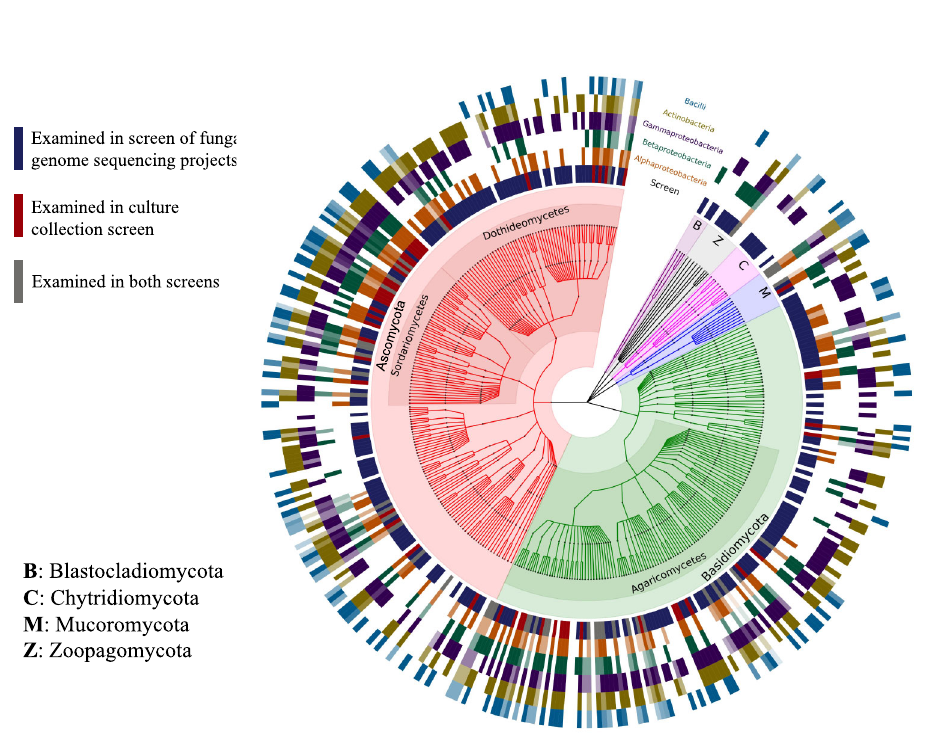
Fig. 3 Diversity of bacteria found among fungi from culture collections and public fungal genome sequencing projects. The internal cladogram is colored by fungal phyla and terminal nodes represent fungal genera. The innermost ring indicates the screen used to detect these bacterial – fungal associations, and the outer fi ve rings represent the top fi ve bacterial lineages (from inner to outer ring: Alphaproteobacteria, Betaproteobacteria, Gammaproteobacteria, Actinobacteria, and Bacilli) most frequently detected in our screens. These rings are shaded from dark (many interactions detected) to white (no interactions